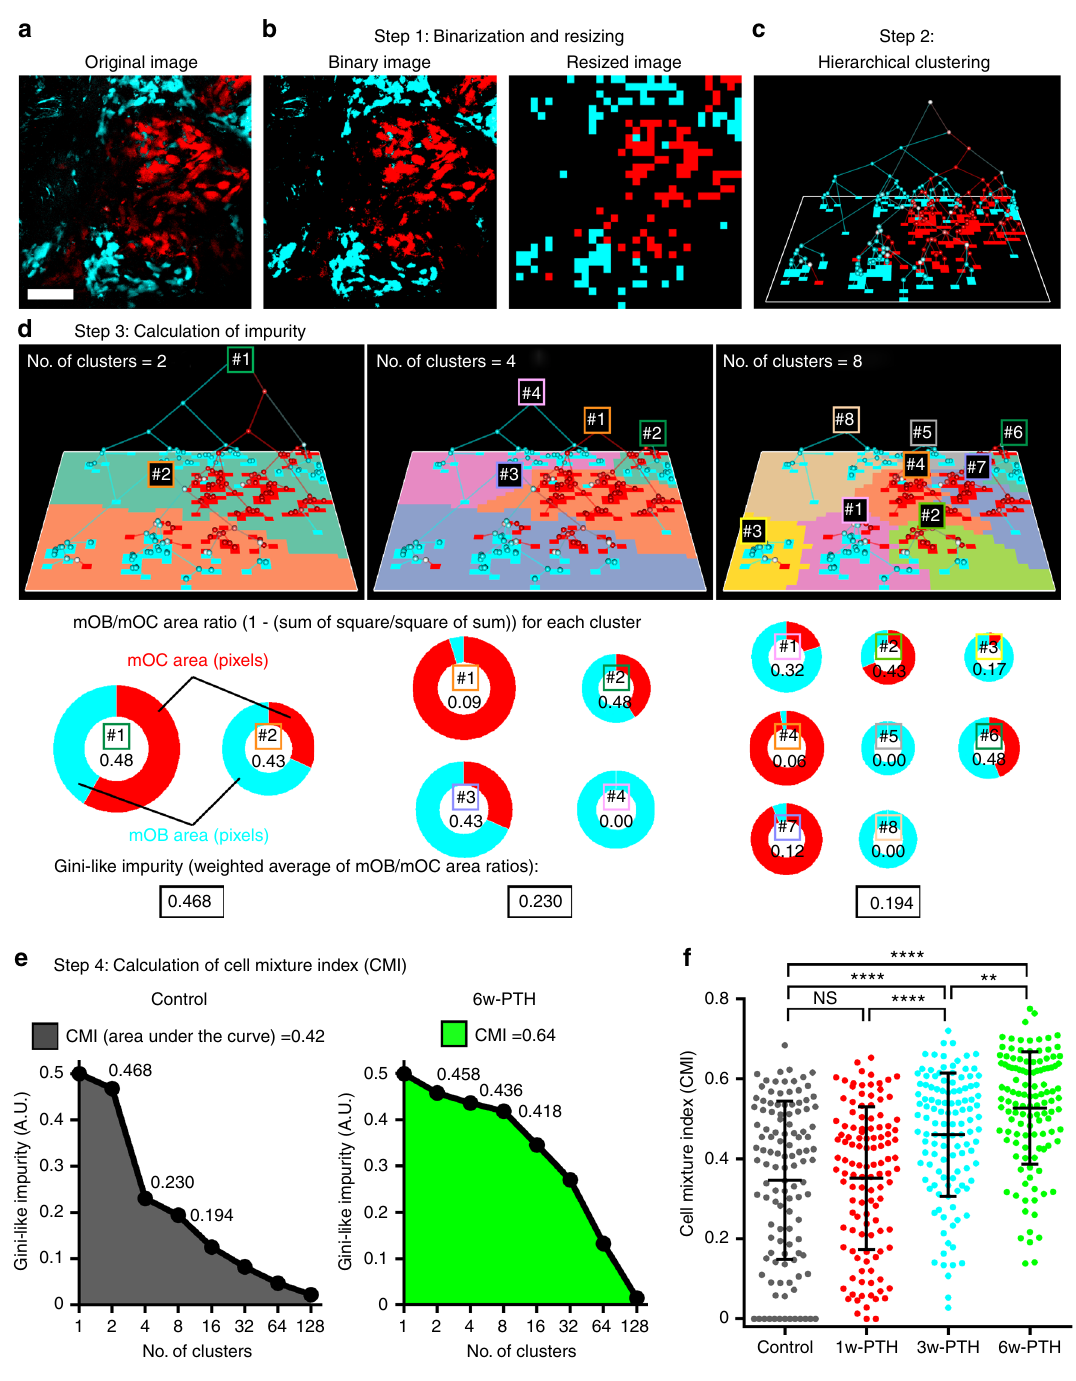
Fig. 4 Quantitative analysis of PTH-induced merged distribution. a – e The procedure used for cell mixture analysis. a A representative, intravital, two- photon microscopy MIP image of the skull bone tissue of a Col2.3-ECFP/TRAP-tdTomato mouse held under control conditions. Cyan, mOBs expressing Col2.3-ECFP; red, mOCs expressing TRAP-tdTomato. Scale bar, 100 µ m. b The areas of mOBs and mOCs shown in a were automatically binarized and the binarized image were resized (smaller). c Hierarchical clustering was performed based on the between-pixel differences, regardless of color. d To derive a threshold allowing the number of clusters to be determined, the Gini-like impurity (GLI) was calculated as the weighted averages of the mOB/mOC area ratios of each cluster at particular levels of the tree. As examples, we present the calculations for the cases in which the cluster numbers were 2, 4, and 8. The clusters used to calculate each threshold are shown in the same colors on the image. The ratios between the mOC and mOB areas are indicated by red and cyan in the circular charts; the areas of the circles re fl ect the areas occupied by the cells. e The GLI curves and the cell mixture index (CMI) values were calculated for the image shown in 4a (left graph) and the magni fi ed image shown in 3f (right graph). The CMI was de fi ned as the area under the GLI curve, which indicated the extent of mixing of the two types of cells within an image. f The CMI values per visual fi eld in control mice and 1-w-, 3-w-, or 6- w-PTH-treated Col2.3-ECFP/TRAP-tdTomato mice; n = 120; collected from 12 tiling images from the six mice of each group. Data are presented as means ± SDs. ** p < 0.01; **** p < 0.0001; NS, not signi fi cant (Kruskal – Wallis